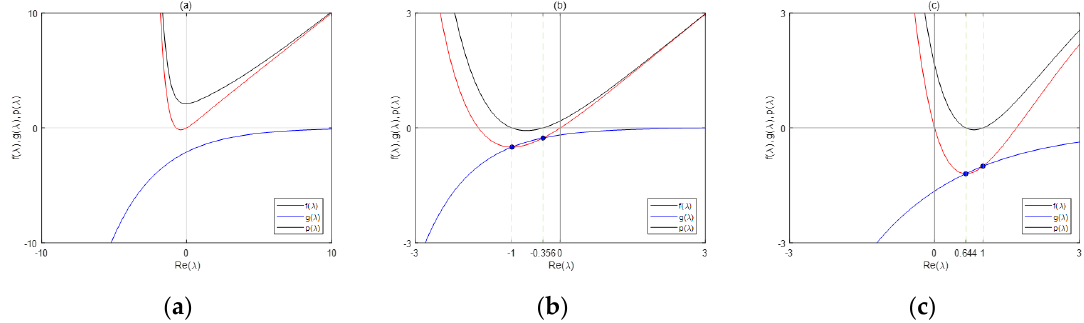
Figure 1. Graphs of the characteristic equation and two functions in Equations (5) and (6). ( a ) Example 1. a = − 0.3, b = 2.1, τ 1 = 1.7, τ 2 = 0.3, ( b ) Example 2. a = − 0.18394, b = 0.18394, τ 1 = 1, τ 2 = 1, ( c ) 1